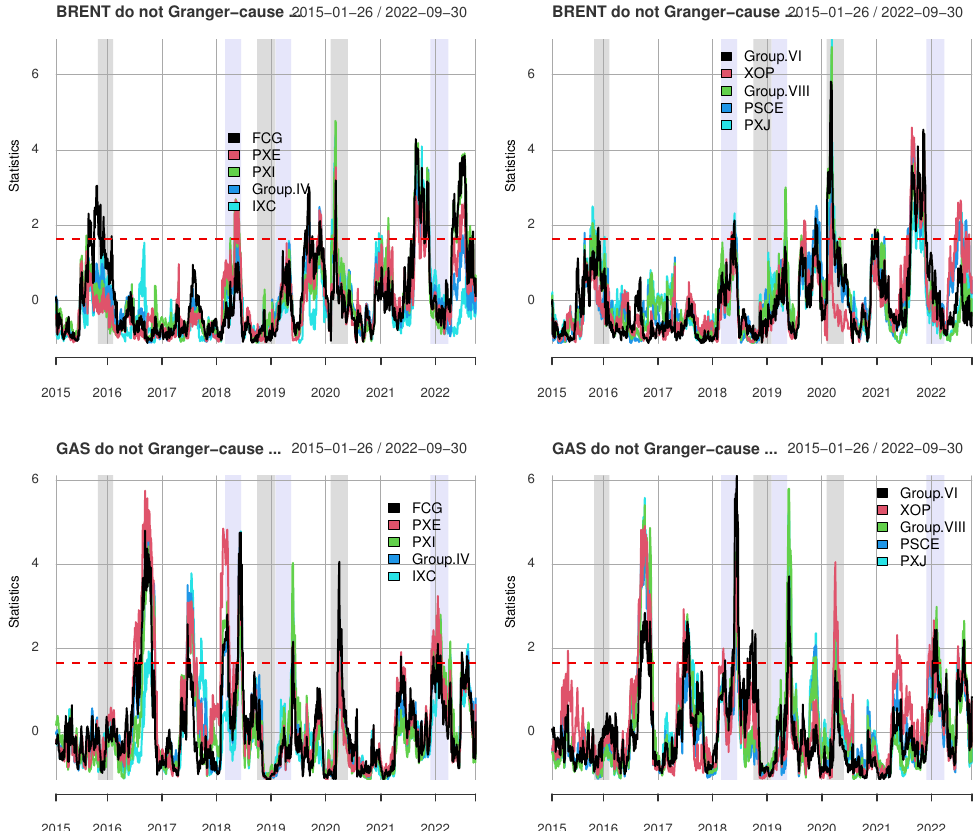
Figure 2. Rolling Hong tests between crude oil, natural gas, and ETFs (causality-in-mean). The red dashed line indicates the critical value of the H 1 test at the 5% significance